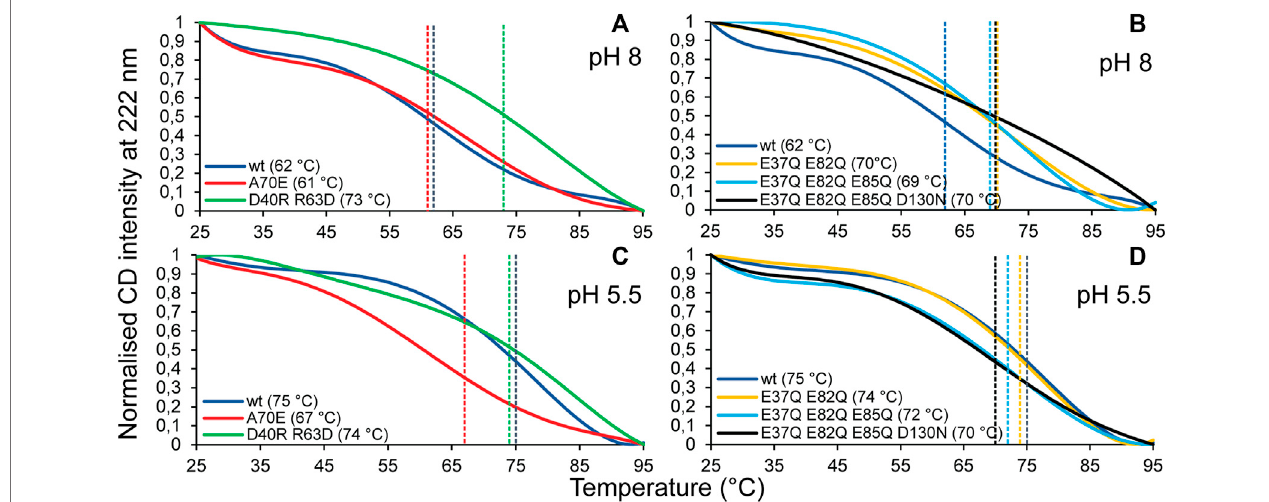
FIGURE 6 | Superposition of the structures of A. argentata TuSp NT dimer (PDB ID 6TV5, cyan and gray) and N. antipodiana TuSp NT monomer (PDB ID 2K3Q, green). Helices of A. argentata TuSp NT are identi fi ed with black font, whereas helices of N. antipodiana TuSp NT are identi fi ed with red font. Hydrophobic residues mutated by Wang et al. (2021) are shown with stick representation in both structures in red ( A. argentata TuSp NT) and in orange ( A. antipodiana TuSp NT).